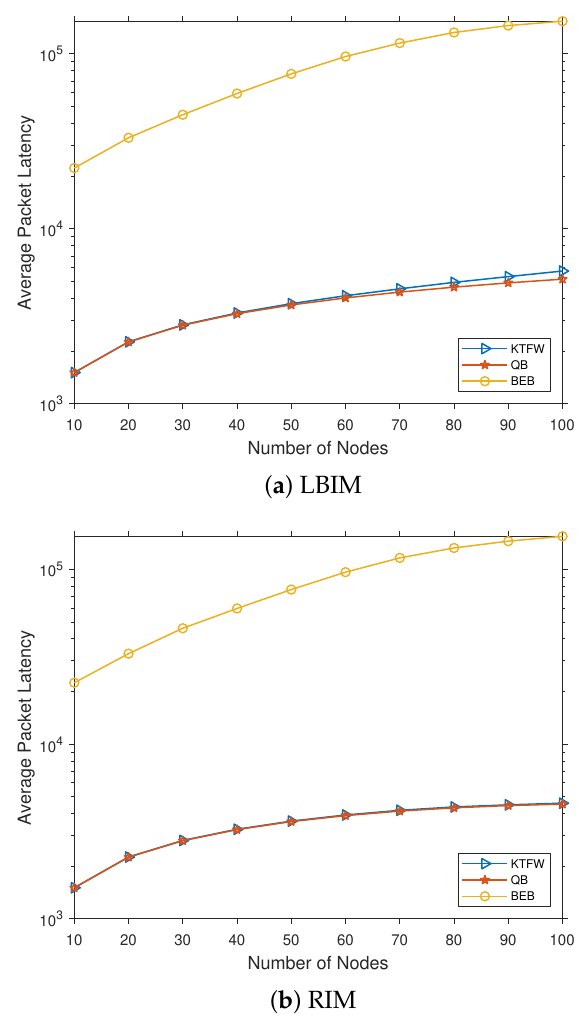
Figure 11. Comparing the average packet latency for the three algorithms (QB, KTFW, and BEB) for all n ∈